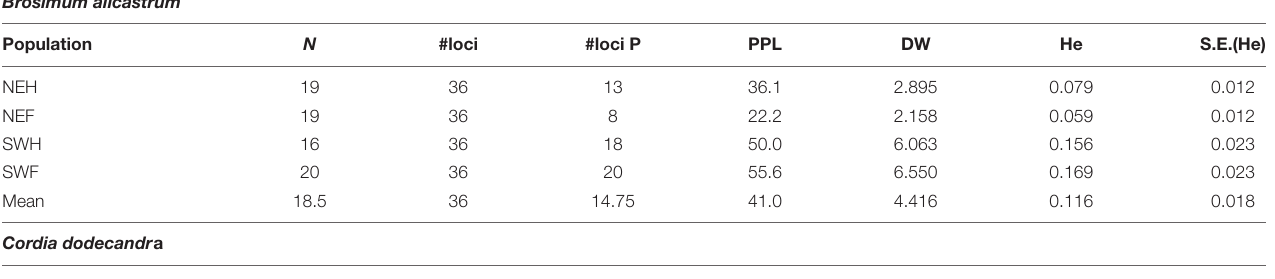
TABLE 1 | Genetic diversity estimators: number of polymorphic loci (#loci P) Percentage of polymorphic loci (PLP), frequency down-weighted marker values (DW), and expected heterozygosity -unbiased Nei-(He) per population type/region and for the mean of the four combinations. Brosimum